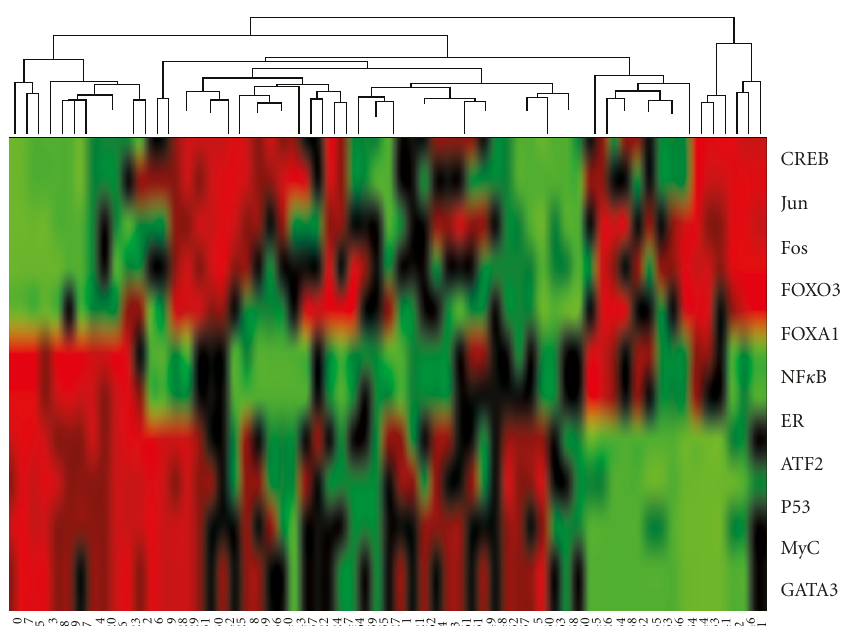
Figure 13: Estimated TF activities in ER − patient samples. The samples (columns) are arranged according to hierarchical clustering and the TFs (rows) according to the estimated clusters by the Gibbs sampling